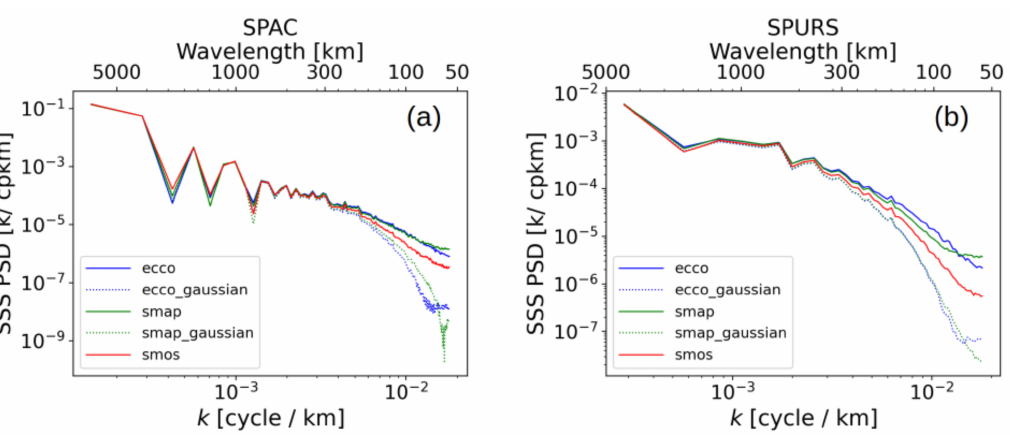
Figure 7. Spectral analysis of SSS from ECCO model (blue), simulated SMAP (green) and simulated SMOS (red) for two different regions ( a ) subtropical North Atlantic (SPURS) (22 ◦ N, 28 ◦ N; 60 ◦ W, 28 ◦ W) and ( b ) South Pacific (SPAC) (50 ◦ S, 14 ◦ N; 128 ◦ W, 112 ◦ W). Dashed lines correspond to the filtered SSS for ECCO (blue) and SMAP